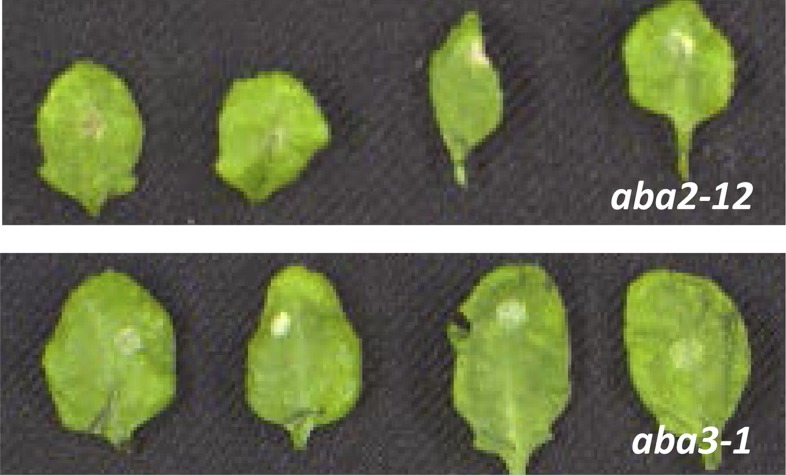
B. cinerea 2100 infection phenotypes of mature 4-week old leaves derived from aba2-12 and aba3-1 mutant plants.Pictures were taken 3 days post inoculation of two 2 μl droplets containing 2.5 × 105 spores to each leaf (leaves were detached after completion of the experiment for photographic purposes only).